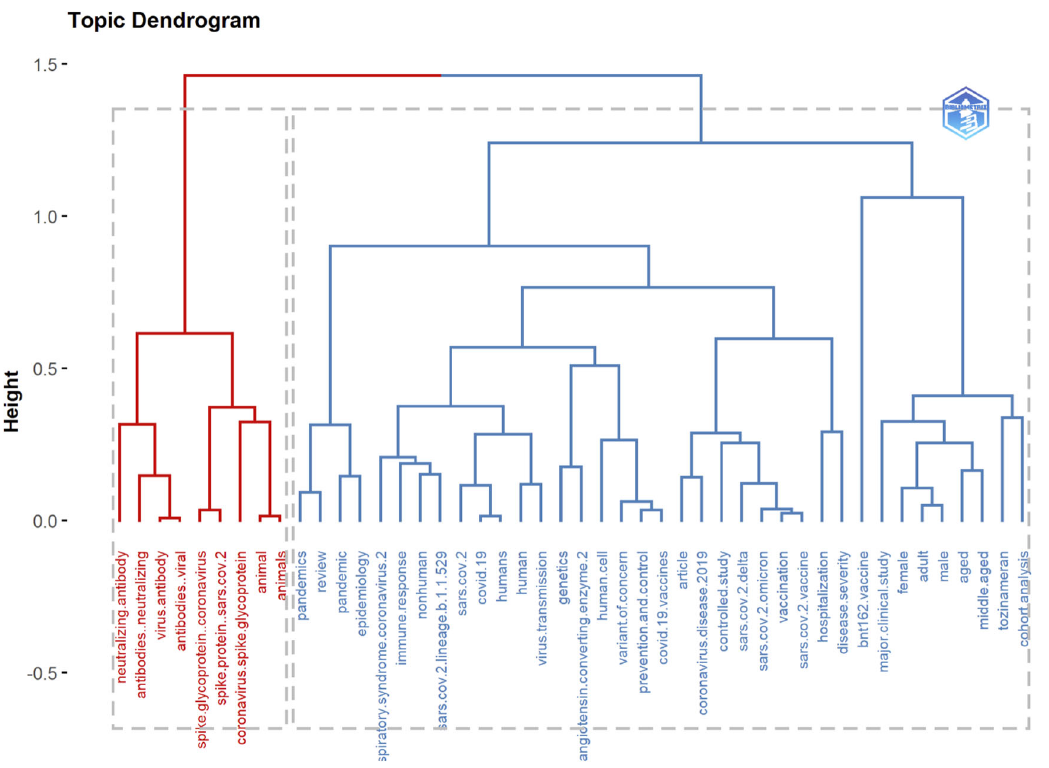
Figure 16. Topic dendrogram using multiple correspondence analysis that shows the hierarchical relationship between topics in the identified field.